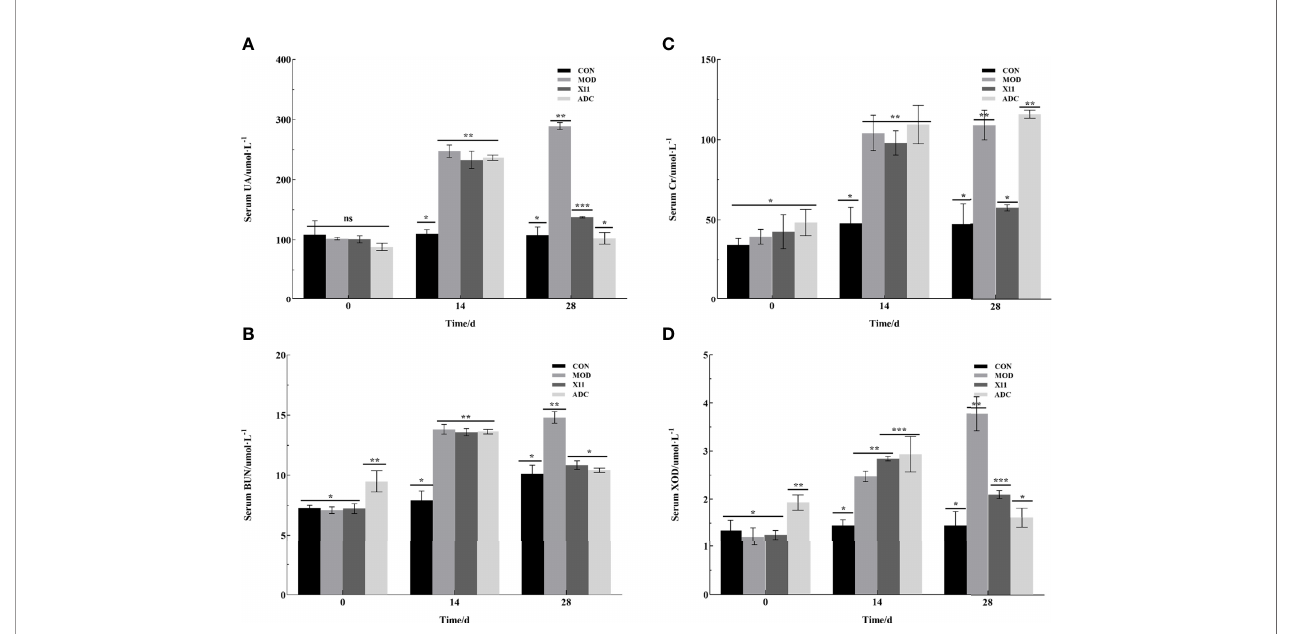
FIGURE 3 | Effects of Lactobacillus paracasei X11 on serum biochemical indicators of mice. (A) UA. (B) BUN. (C) CRE. (D) XOD. UA, uric acid; BUN, blood urea nitrogen; CRE, creatinine; XOD, xanthine oxidase. The same number of asterisks indicates no signi fi cant difference and the different number of asterisks indicates signi fi cant difference. (P <